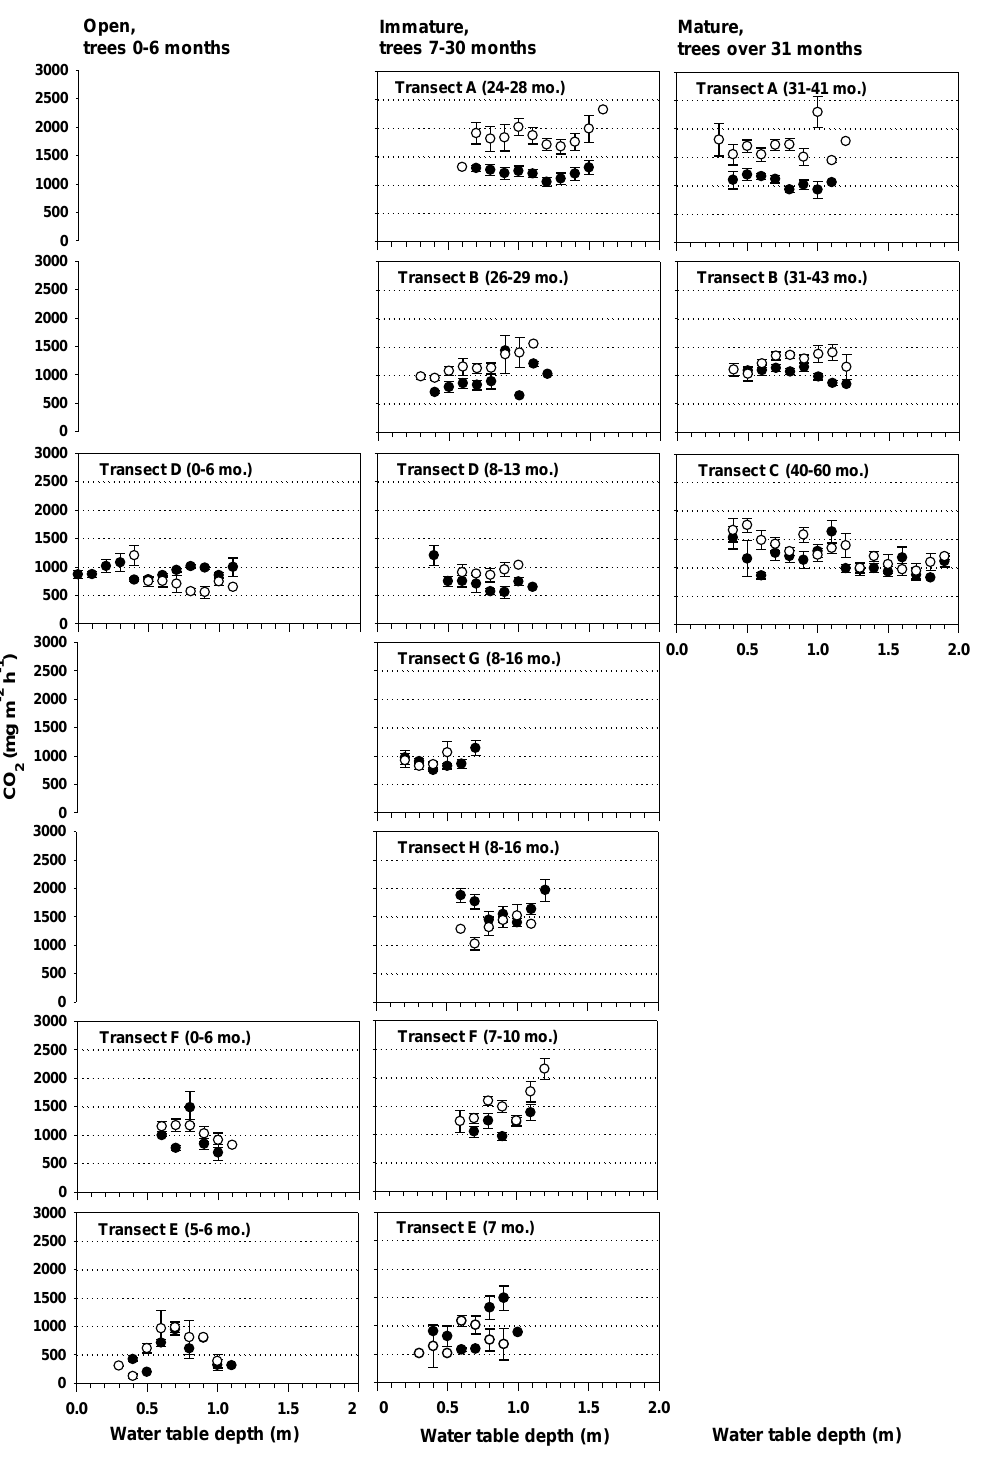
Fig. 2. Instantaneous daytime CO 2 emissions (mean ± SE) at transects representing various tree growth stages using 10 cm wide water table depth classes. Mean CO 2 emissions from heterotrophic respiration ( • ) and total soil CO 2 emissions ( ◦ ) are shown separately for each transect. Note that mean total CO 2 emissions especially in open and young immature growth stages have non-existent or low autotrophic respiration and thus the two flux symbols may be of variable order.